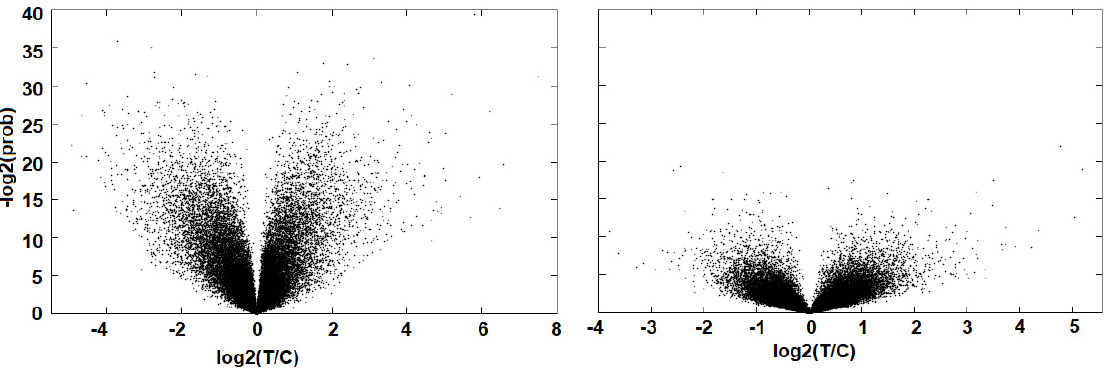
Figure 2. Volcano plot of genes significantly perturbed by AM630. The response is substantial in the core cells ( left ) but relatively dampened in the invasive margin cells ( right ).